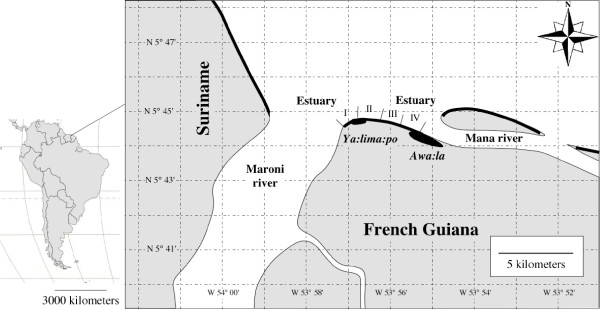
Map of Ya:lima:po beach within the estuary of the Maroni and Mana rivers. Nesting beach sections used in this study are indicated in bold.